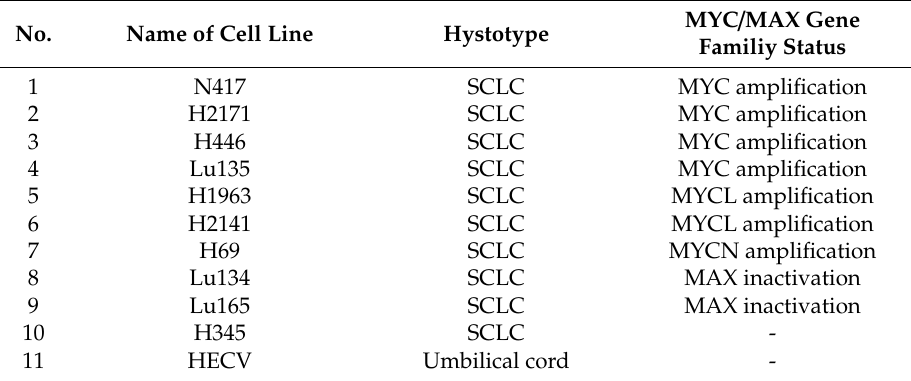
Table 1. Cell lines used in drug screenings assay.